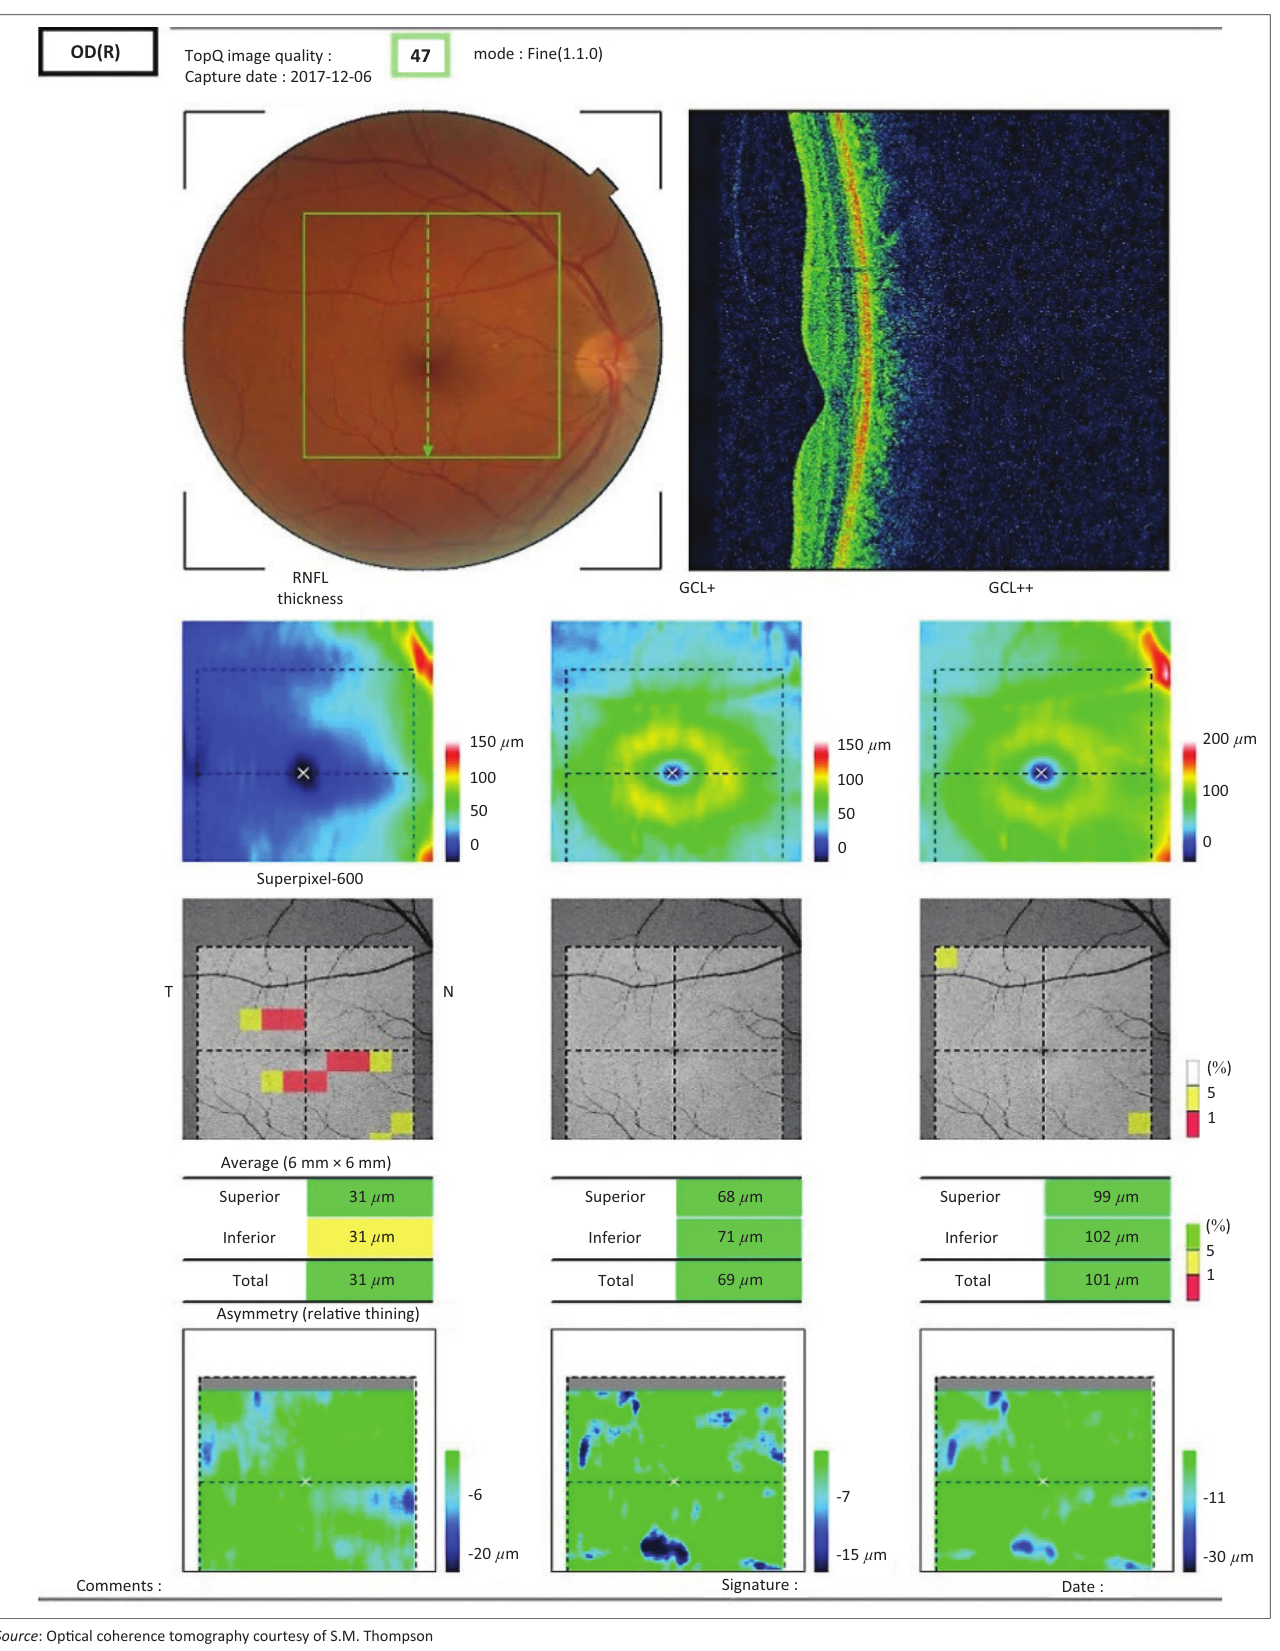
FIGURE 4: Optical coherence tomography scan for the right eye showing a more normal fundus with a healthier ganglion cell